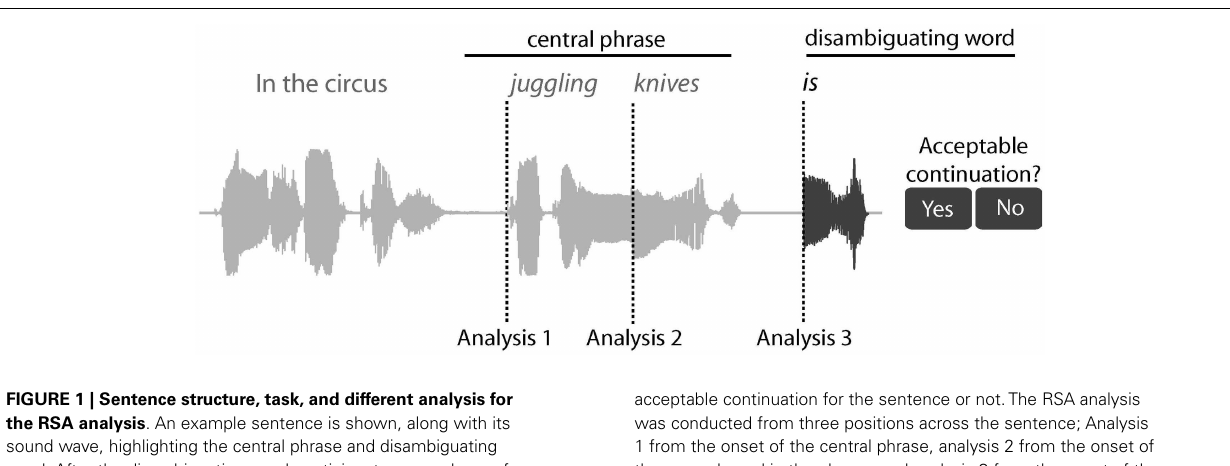
acceptable continuation for the sentence or not.The RSA analysis was conducted from three positions across the sentence; Analysis 1 from the onset of the central phrase, analysis 2 from the onset of the second word in the phrase, and analysis 3 from the onset of the disambiguating